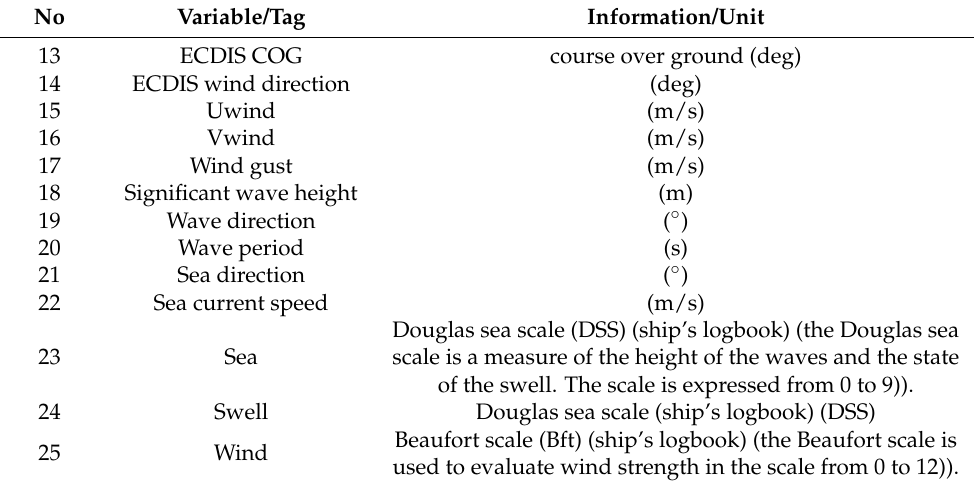
Table 3. List of sensors/tags from secondary data